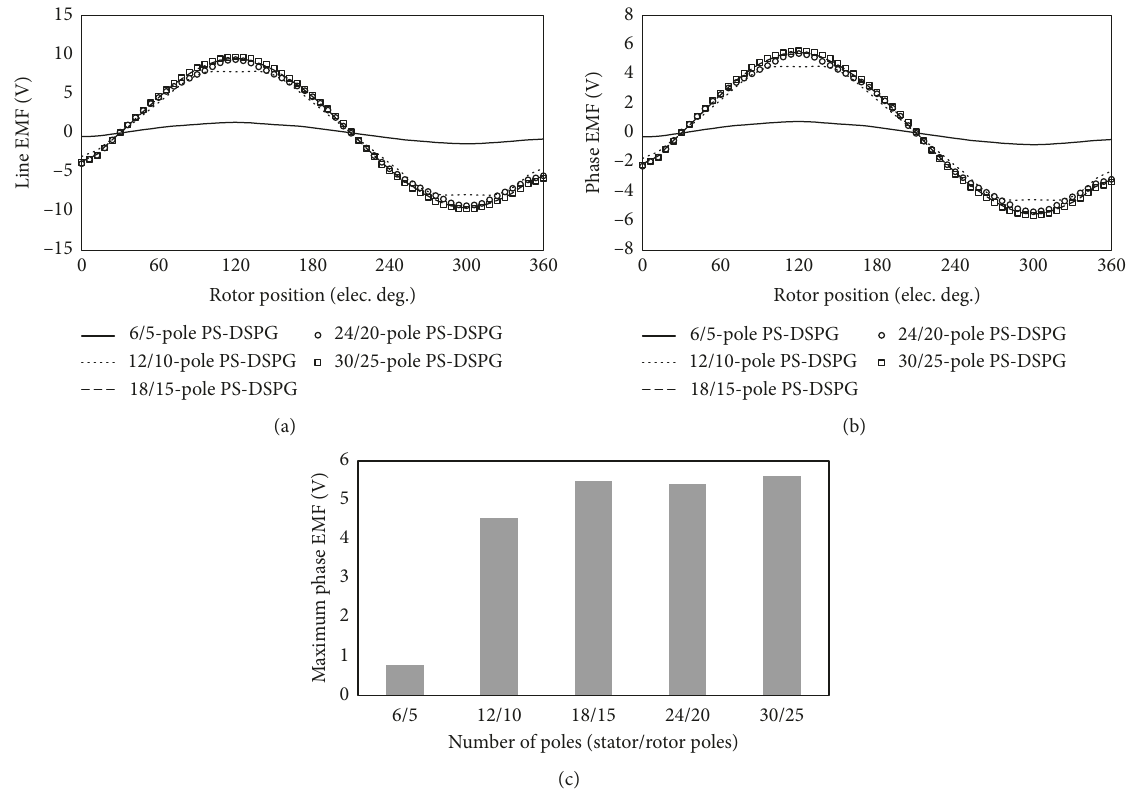
Figure 4: Open-circuit of proposed PS-DSPG structures: (a) line EMF, (b) phase EMF at various rotor positions, and (c) phase EMF indicating the maximum value of each structure.